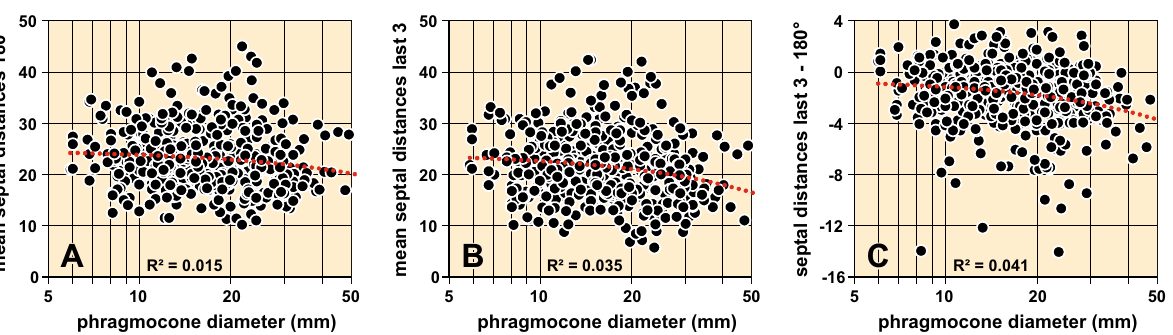
Fig. 7 Bivariate plots of phragmocone diameter and septal spacing of all analysed specimens ( n volution. B Septal spaces of the last three septa. C Difference in the septal spaces of the last three septa all septa in the last half